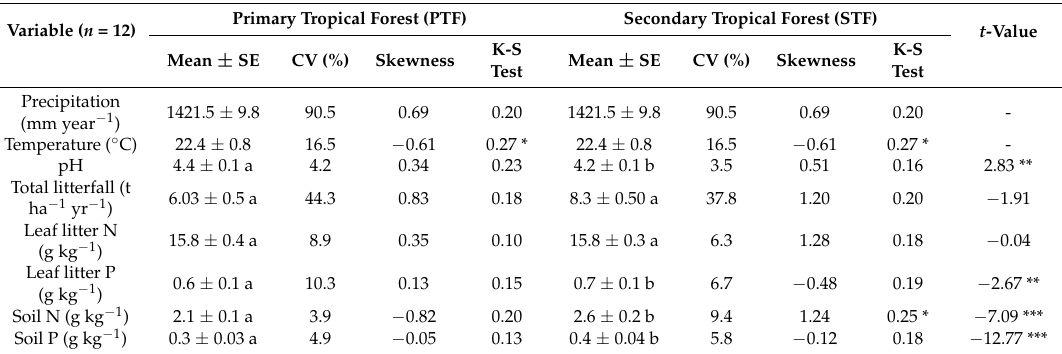
Table 1. Summary of mean variables from the study